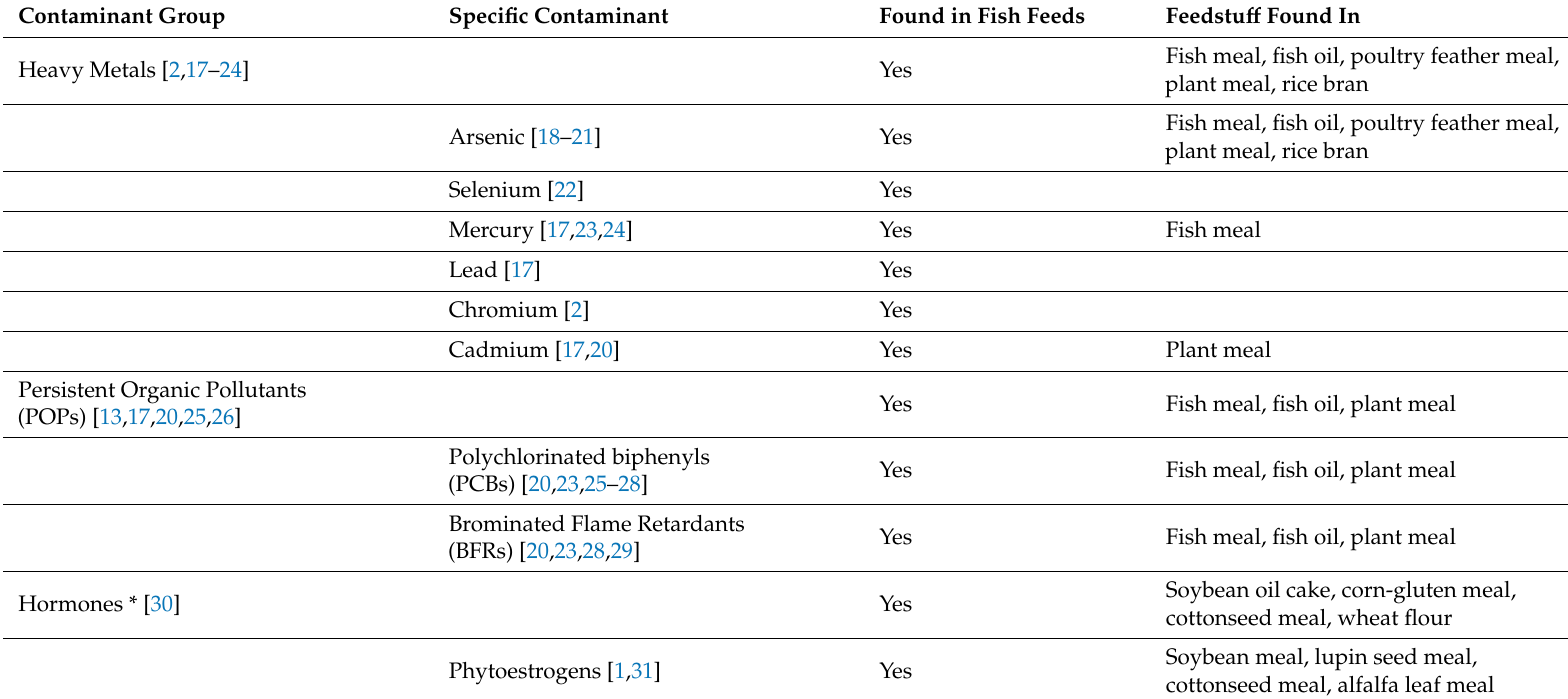
Table 1. Contaminants found in fish feeds and specific feedstu ff s for the formulation of fish